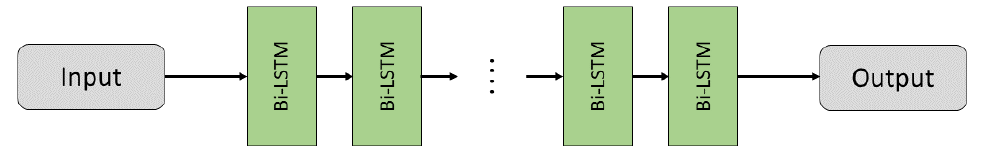
Figure 4. Stacked Bi-LSTM structure adopted in the present